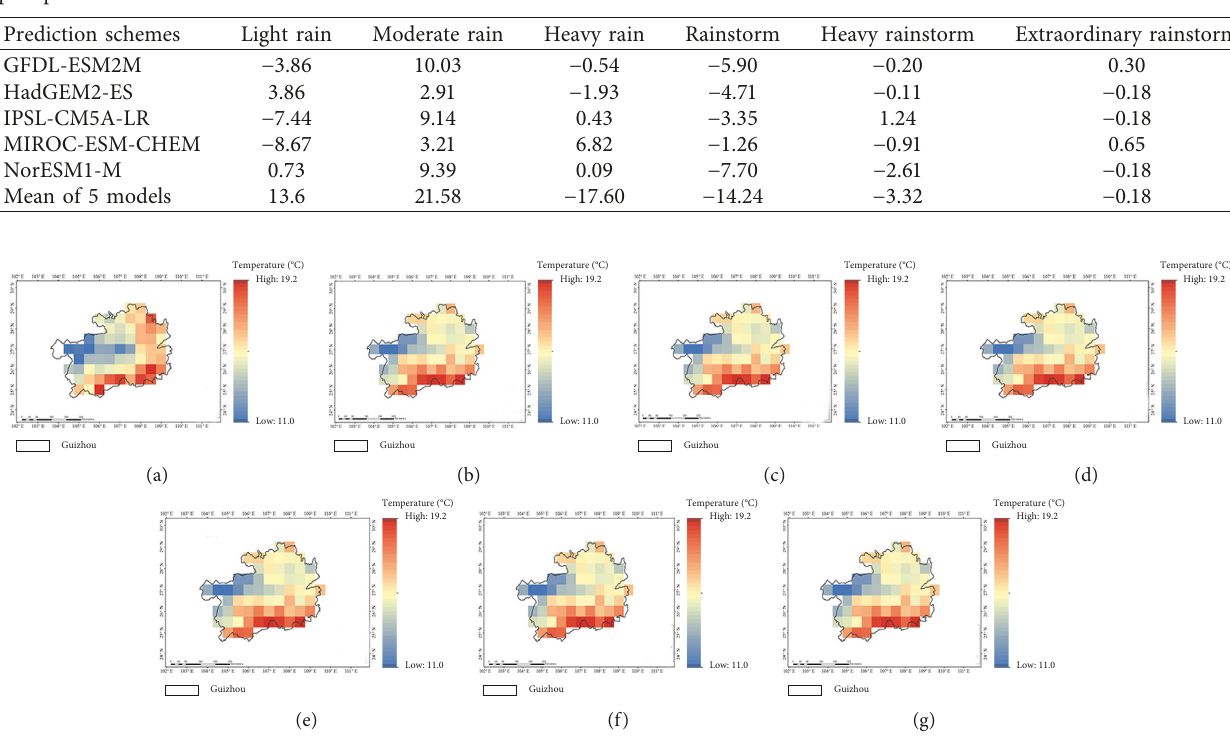
Table 9: The difference between simulated value of the precipitation of in different grades simulated by each mode and the measured precipitation from 1961 to 2000.